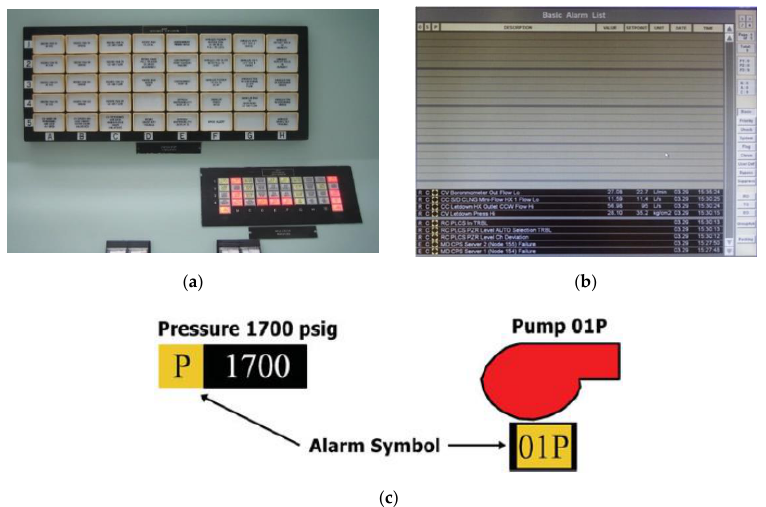
Figure 2. Examples of alarm presentations: ( a ) a tile presentation of alarms in the conventional MCR; ( b ) a list presentation of alarms in the APRMCR; ( c ) a process mimicking alarms in the APRMCR [17].